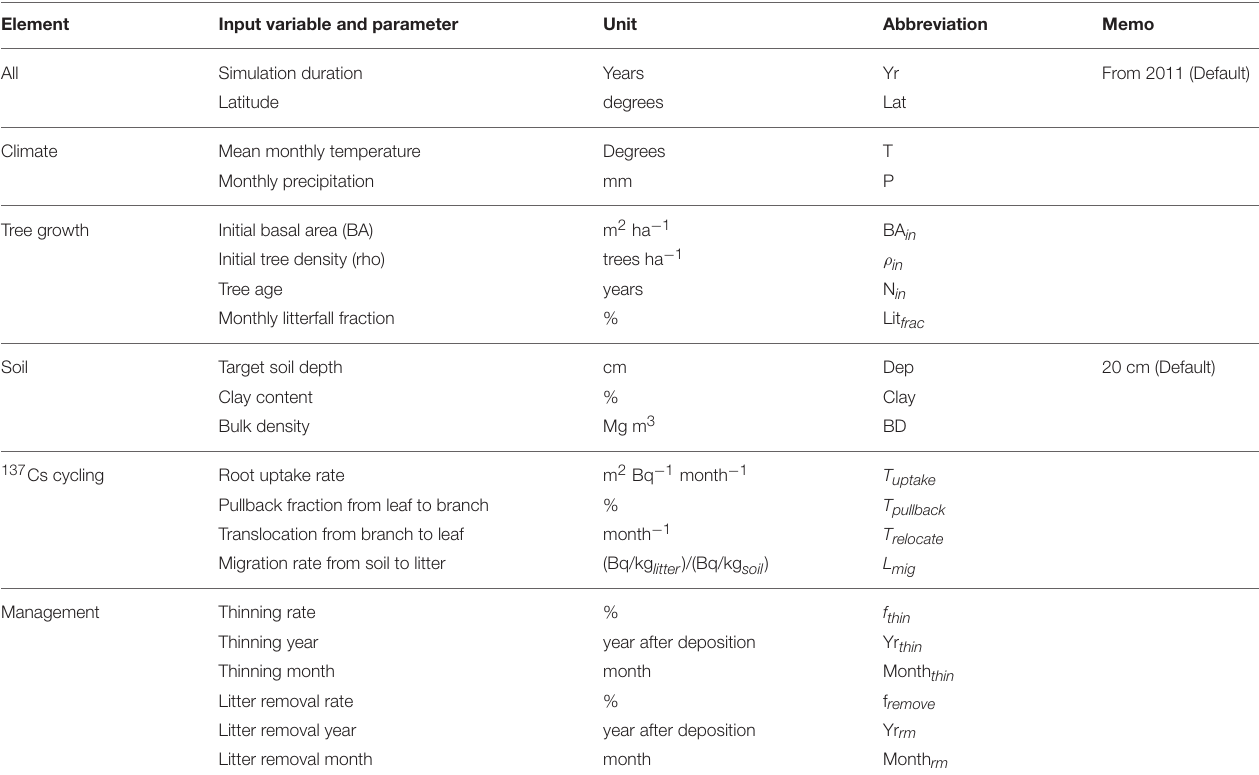
TABLE 1 | Input parameters for the FoRothCs model. Element Input variable and parameter Abbreviation